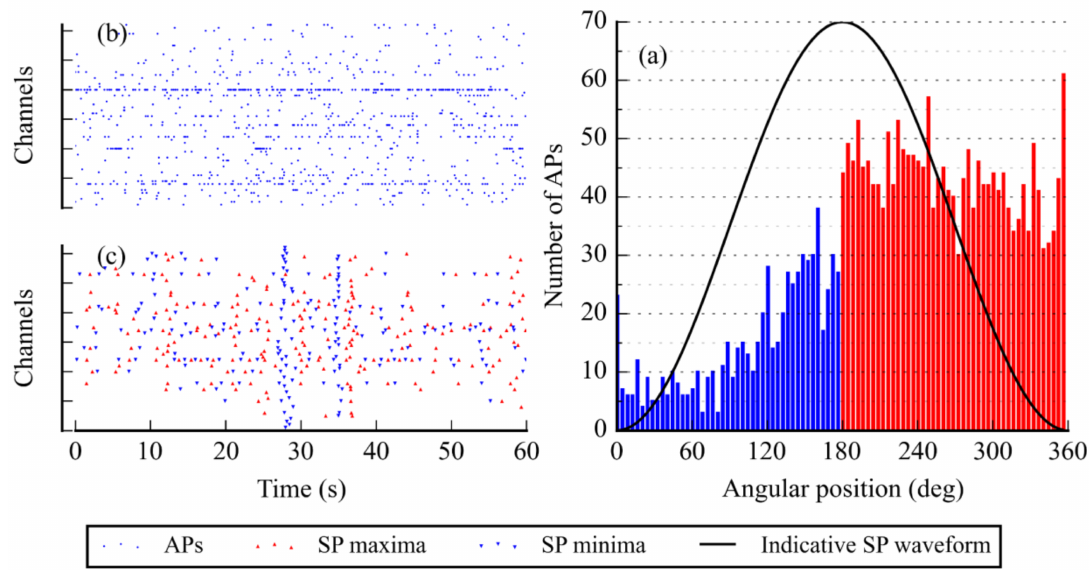
Figure 13. ( a ) Histogram of the angular position of APs on SPs, detected in real-time. Classes are 4 ◦ -wide and sort 2608 APs from 329 SPs; and, ( b , c ) Sample raster plots of AP and SP real-time detection, used as a base for the histogram. The recordings used lasted 300 s in